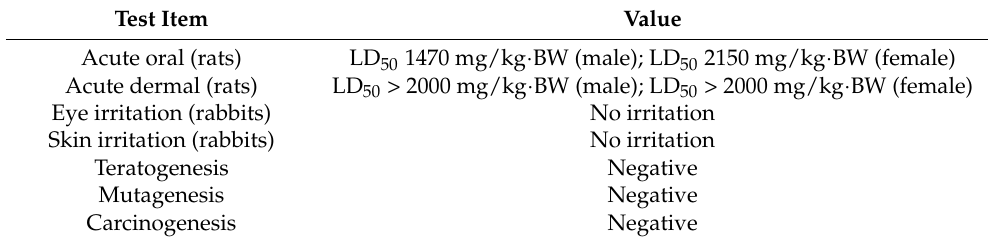
Table 4. Toxicological profile of L13